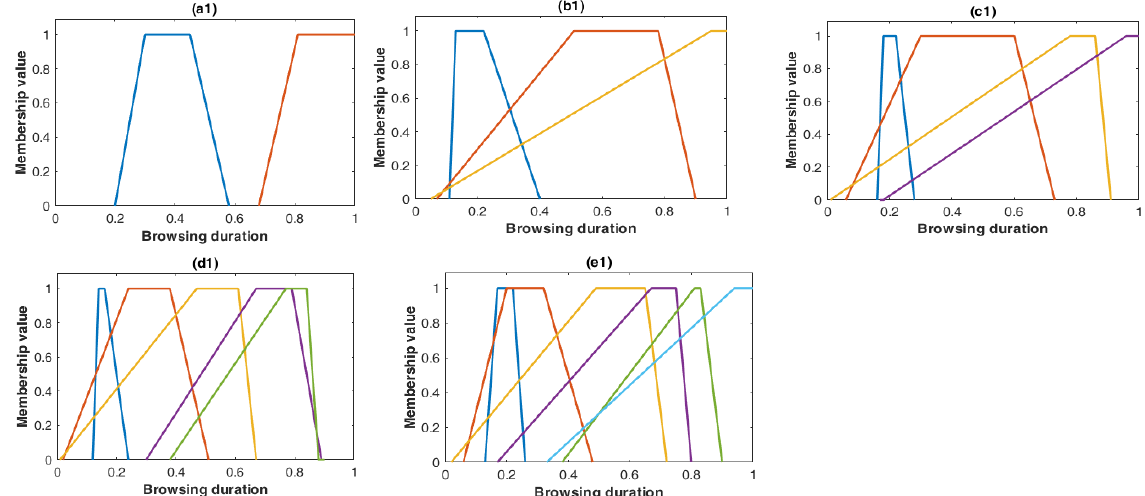
Figure 11 . Initial membership functions before executing LA-OMF in the CTI dataset.